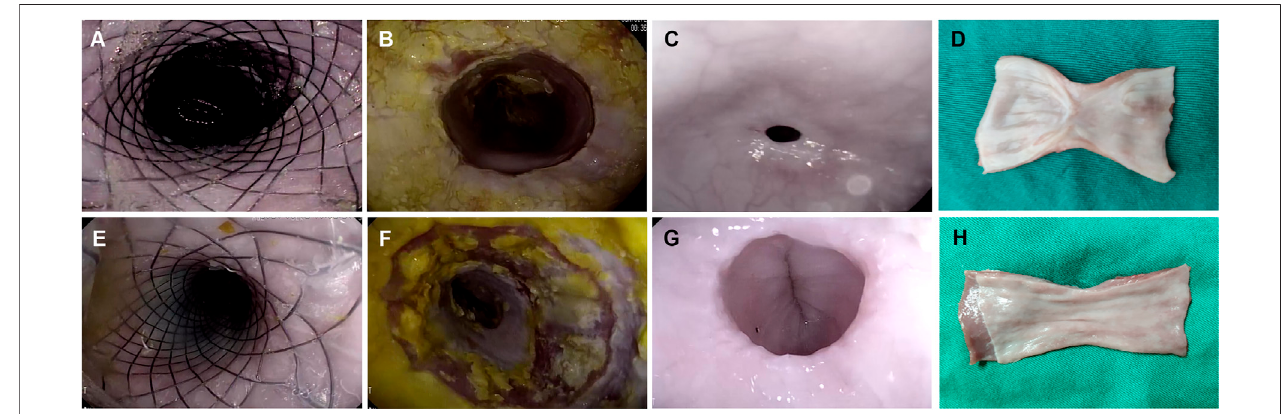
FIGURE 3 | Comparison between the ADM-FCSEMS group (A) and FCSEMS group (B) by endoscopic and macroscopic evaluations. (A,E) Endoscopic appearance immediately after full circumferential endoscopic submucosal dissection (ESD) and stent placement in both groups. (B,F) Endoscopic appearance at week 2post-ESD.NoobviousesophagealstricturesingroupsAandB. (C,G) Endoscopicappearanceatweek4post-ESDingroupsAandB.Agreateresophagealdiameter and better patency can be observed on endoscopy in group A than in group B. (D,H) Macroscopic views of the harvested esophageal specimen show better wound healing and lesser mucosal contraction in group A than in group